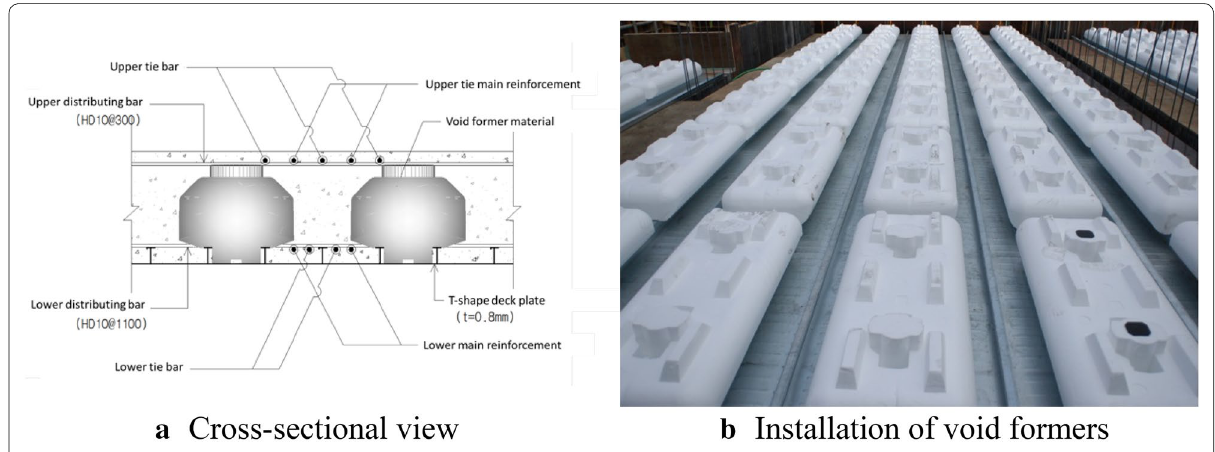
Fig. 1 Details of the voided slab